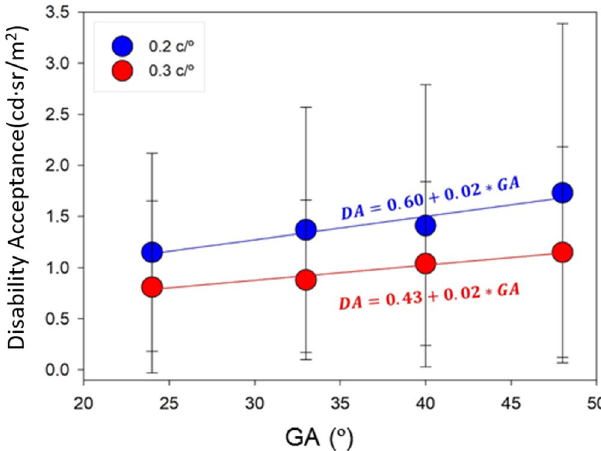
Figure 3. Graphical representation of the DA parameter as a function of angular size of the glare source and linear regression for spatial stimulus frequencies of 0.2 (blue) and 0.3 c/°